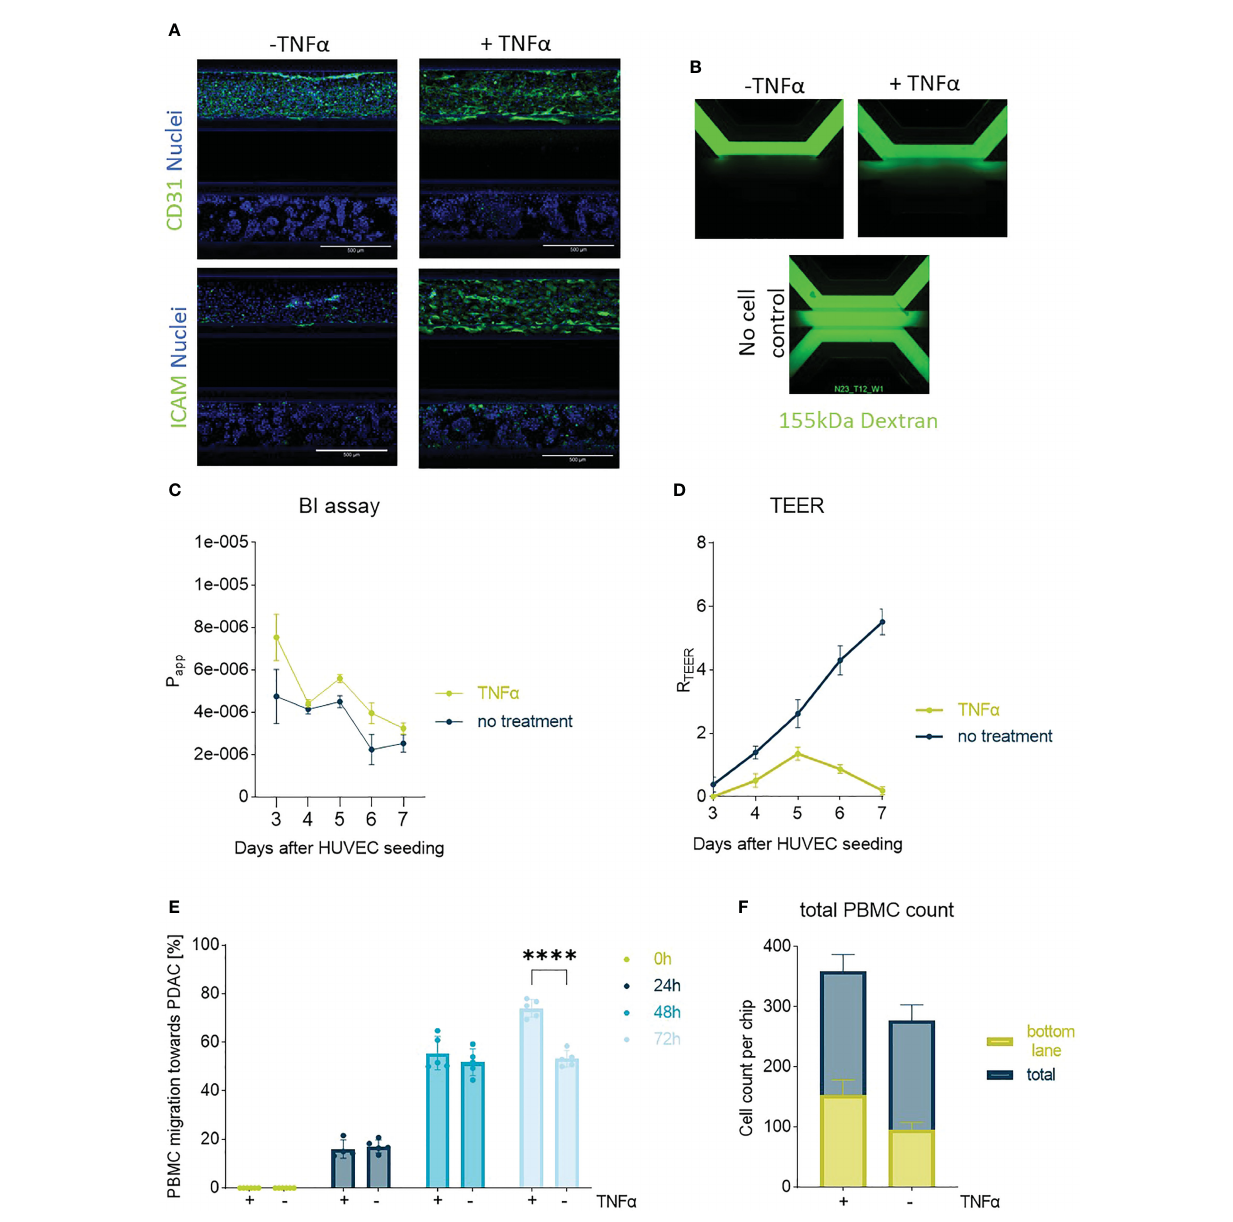
FIGURE 2 Endothelial barrier function and PBMC migration: In (A) one of the PDAC-on-Chip model setups is shown, and consists of a HUVEC tubule and PDAC organoids. Confocal imaging revealed the morphology of the HUVEC tube upon treatment with TNF a on day 3. The cells were stained on day 7 with CD31 (green), ICAM (green) and NucBlue (blue). Shown are 10x maximum intensity projections, imaged on the the ImageXpress Micro Confocal (Molecular Devices). Scale bar= 500 µm. (B) BI assay determined upon perfusion of a 155 kDa FITC-dextran. The dye diffused through